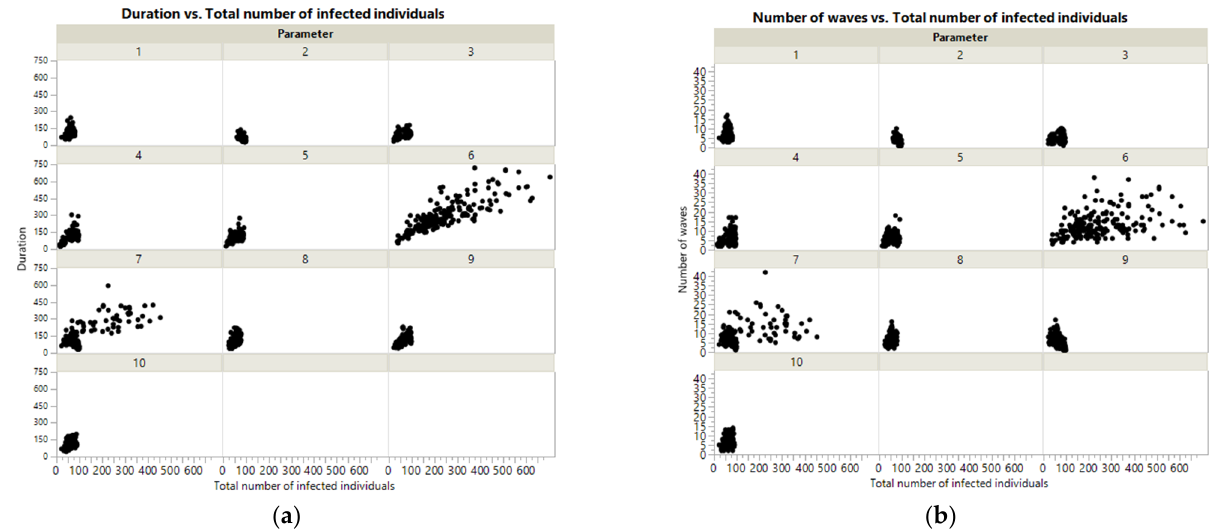
Figure 9. The relation between the output responses per parameter: ( a ) duration of the epidemic vs. the total number of infected individuals; ( b ) number of waves vs. the total number of infected individuals.